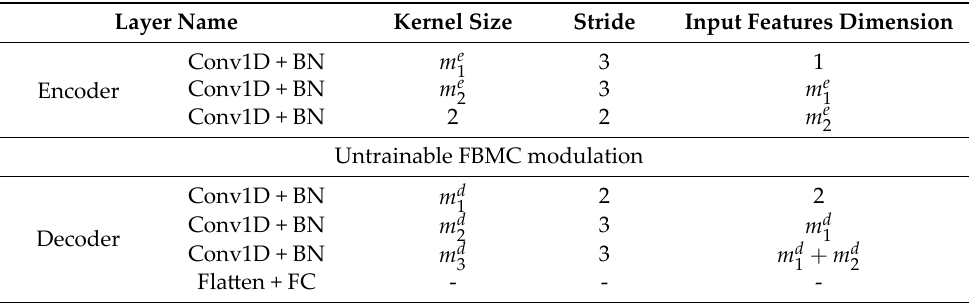
Table 1. Parameter settings of autoencoder network.